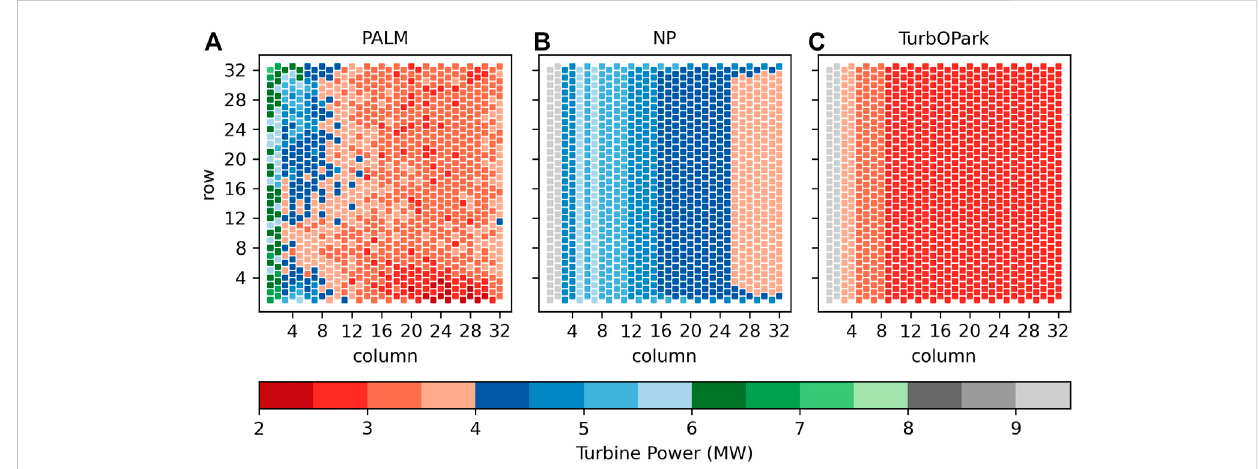
FIGURE 10 Wind turbine power of the LES model PALM (A) , the Niayifar and Porté-Agel model (B) and the TurbOPark model (C) . For PALM, the power is averaged over the last 4 h of the main simulation.